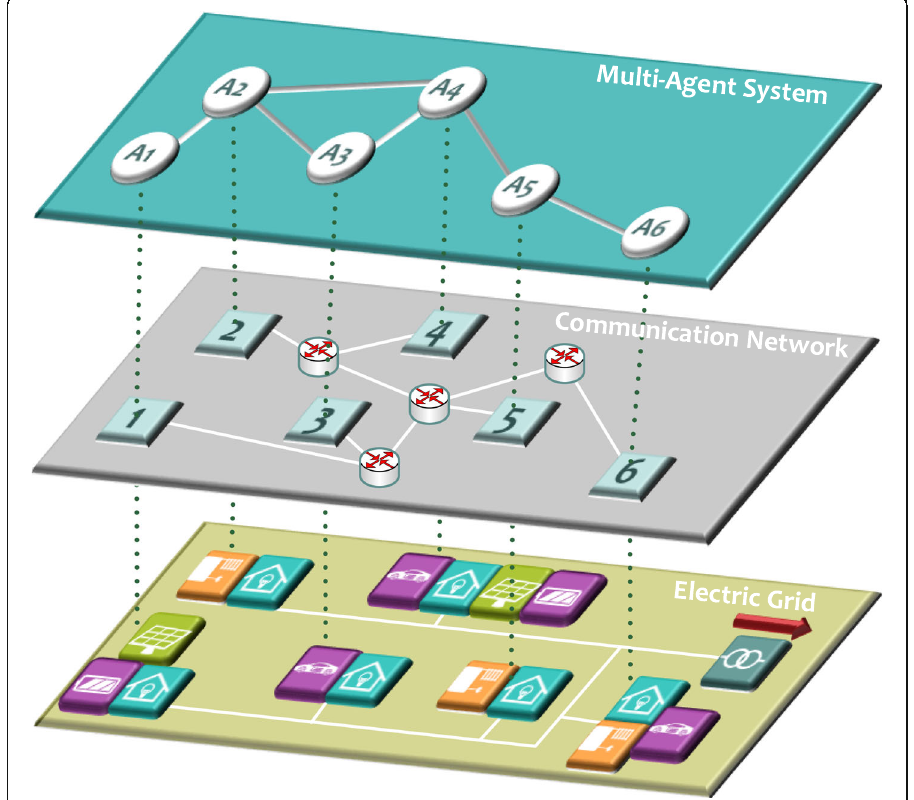
Fig. 2 Exemplary overlay network on top of communication infrastructure and smart